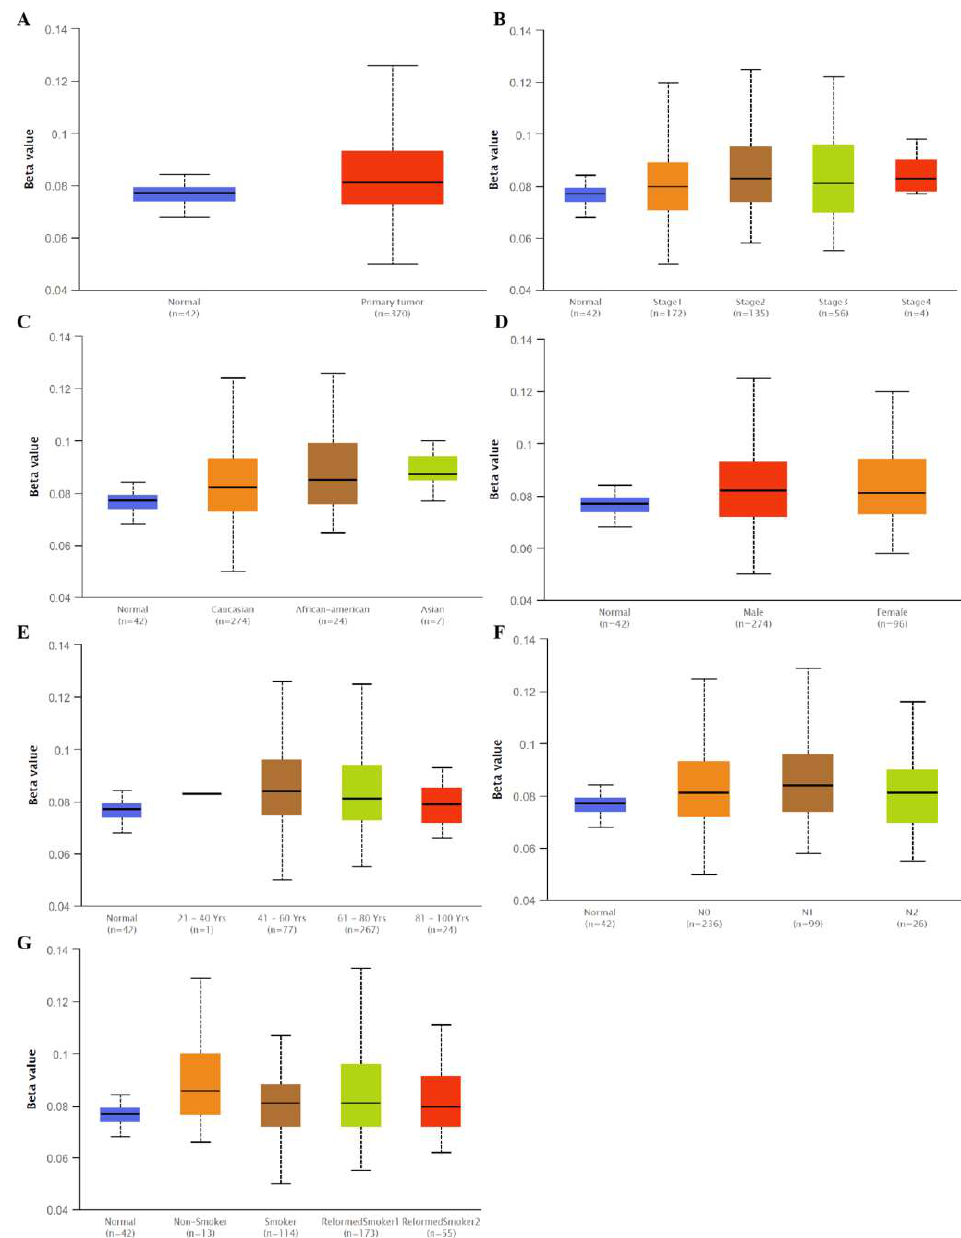
Figure 4. Methylation status of SLC3A2 in tumor tissues and in matched normal tissues from different subgroups of LUSC patients. ( A ) Sample type; ( B ) Stages; ( C ) Race; ( D ) Gender; ( E ) Age; ( F ) Nodel metastasis; ( G ) Smoking habits.